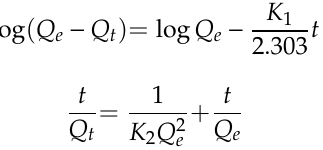
Table 4. Freundlich and Langmuir isotherm model parameters for the adsorption of Pb(II) onto CLNPs.